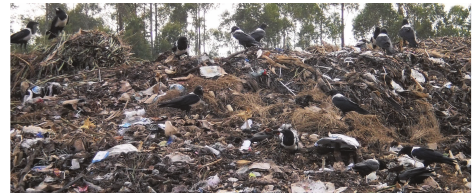
Figure 13: Abundance of Pied Crows in a landfill within Musanze city (Photo Author,